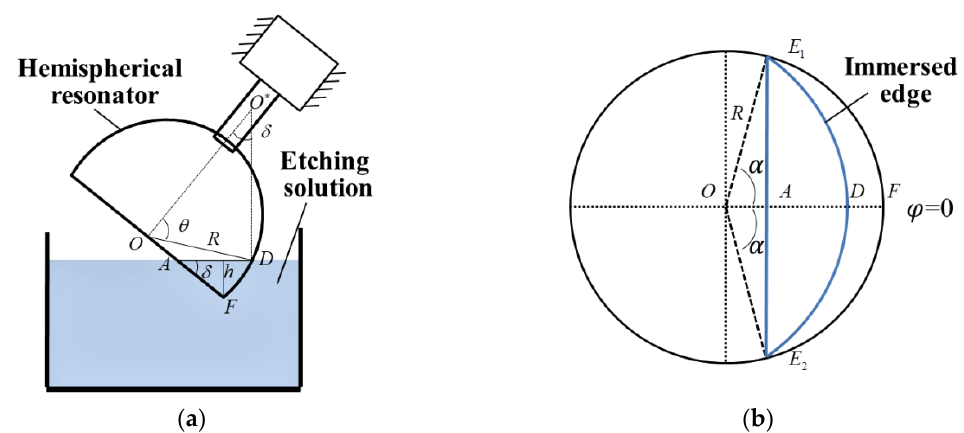
Figure 2. Schematic of main parameters in chemical etching procedure. ( a ) The hemispherical resonator with radius R is immersed into the etching solution, with an immersion depth h and an inclination angle δ ; ( b ) The immersed edge is projected onto the plane of the resonator cup [29], the zenith angle of which is α .